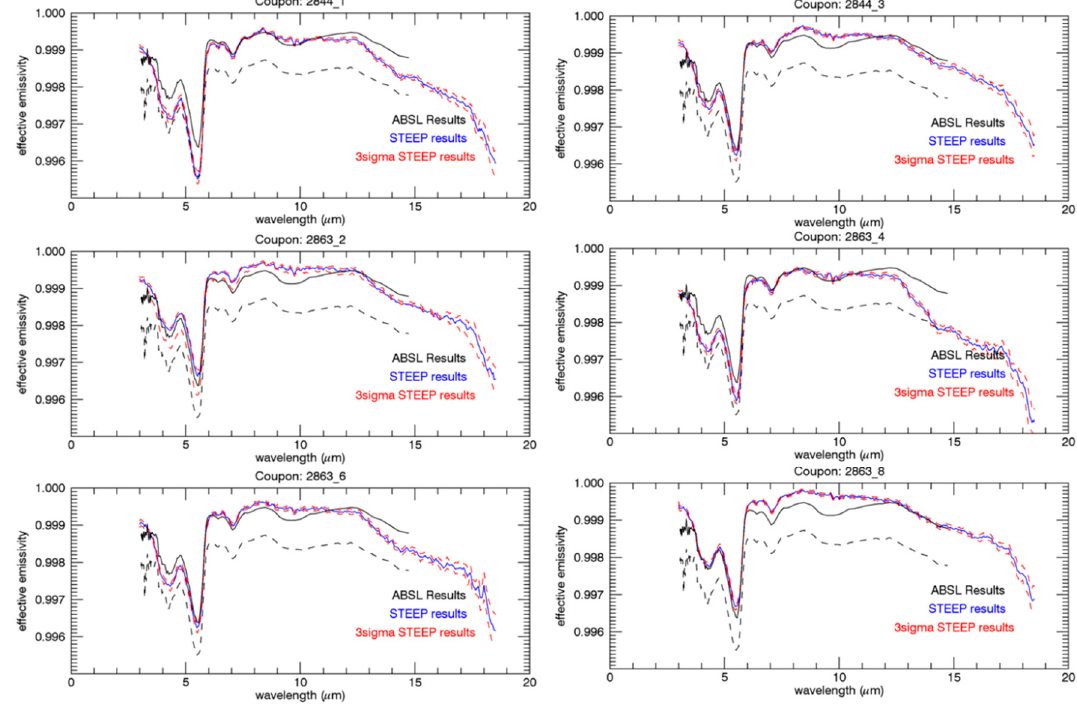
Figure 5. Comparison of STEEP 323 and SMART3D results of the SLSTR BB Cavity geometry deduced from NIST measurements of the black-coating. The solid lines refer to the original ABSL analysis, the blue curve the analysis using the STEEP323 software.